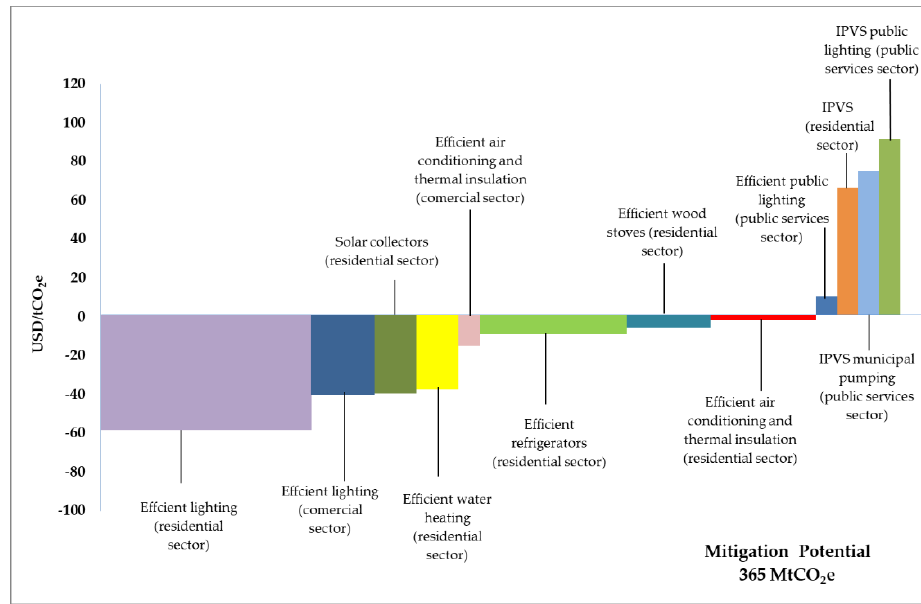
Figure 6. The mitigation cost curve for energy efficiency and solar energy options in the RCPS sectors. Source: Own elaboration.